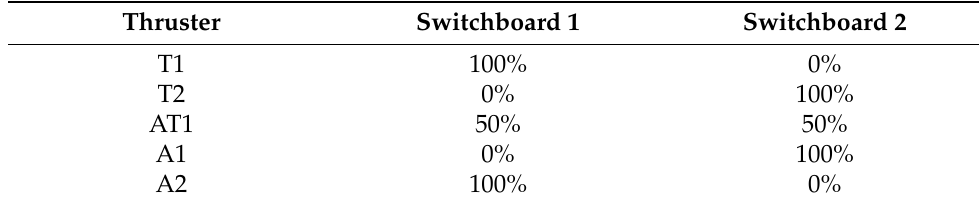
Table 5. Power consumption of individual